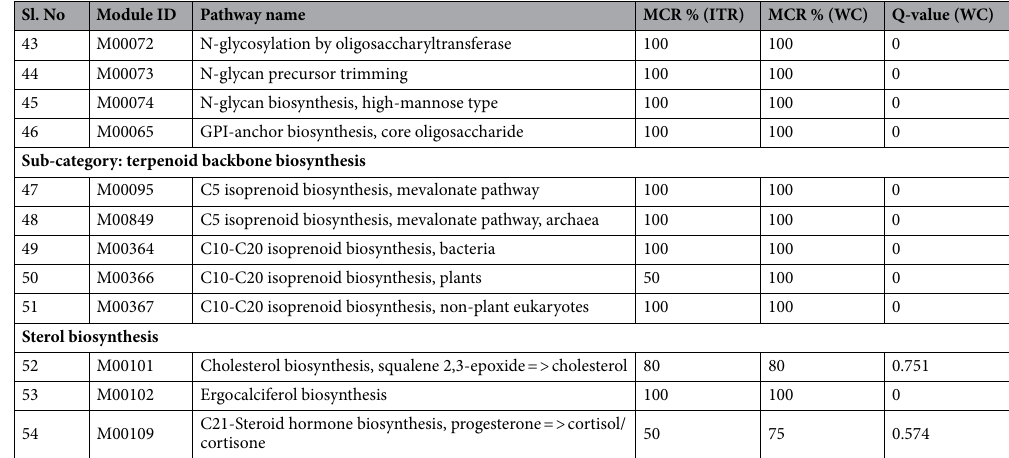
Table 3. Carbohydrate and lipid metabolism pathways as predicted in emao by MAPLE system. Metabolic pathways with 75% or more module completion ratio (MCR) were shown for the whole microbial community (WC). ITR individual taxonomic